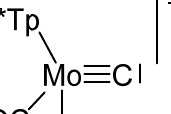
[121] Figure 29. Selected structure of compounds with the [Mo] − C moiety. 3.7. Unique Mo Carbido Complex A further unique carbido complex was described recently as shown in Figure 30. A signal at 360.8 ppm in the 13 C NMR spectrum was assigned to the ligand carbon atom [123]. Figure 30. The carbido complex with the P 2 (CO)Mo ≡ C core. 3.8. The System [Tp*W(CO) 3 ≡ C] − ([W] − C) Reaction of [W]C-Li(THF) with NiCl 2 (PEt 3 ) 2 produced the complex [W]C → NiCl(PEt 3 ) 2 in Figure 31 [124]. Similarly, with [W]C-Li(THF) and FeCl(CO) 2 Cp or HgCl 2 the compounds [W]C → Fe(CO) 2 Cp and [W]C → Hg ← C[W], respectively, were obtained. [W]C → AuPEt 3 was prepared from reacting [W]C → SnMe 3 with AuCl(SMe 2 ) followed by addition of PEt 3 . A similar